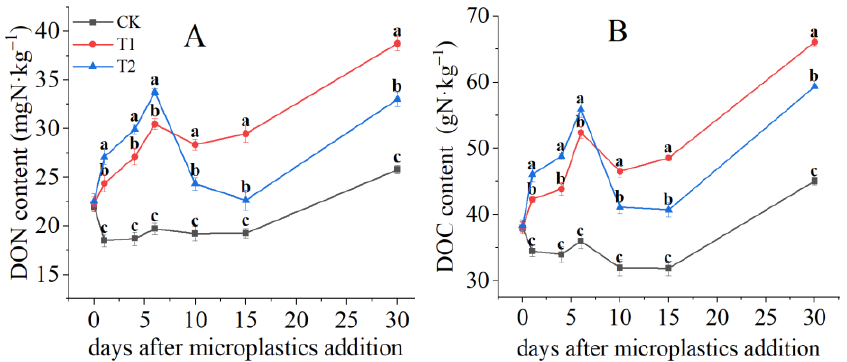
Figure 2. Temporal variations of soil DON ( A ) and DOC contents ( B ). Letters designate significant differences among treatments ( p < 0.05).